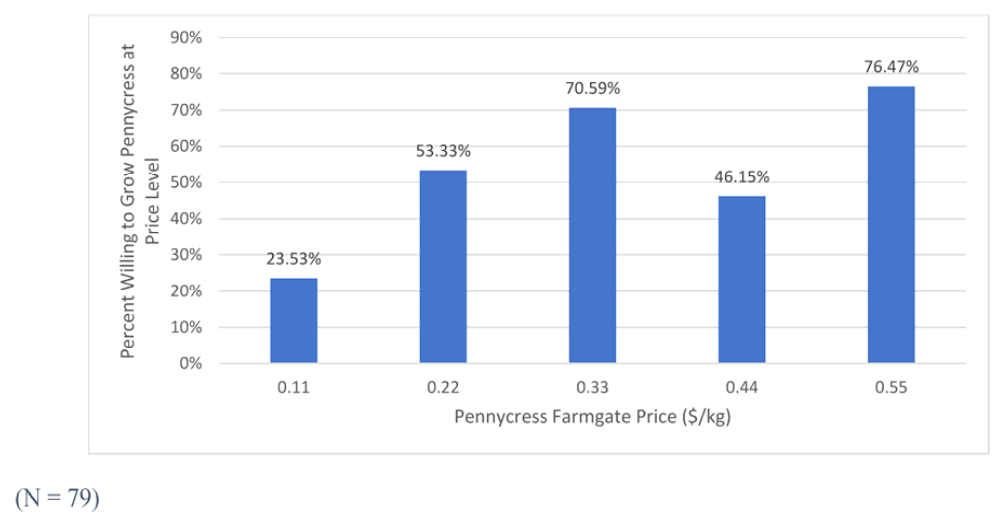
Figure 5. Percent of row crop farmers in seven US states who were willing to grow pennycress at the pennycress farmgate price offered.